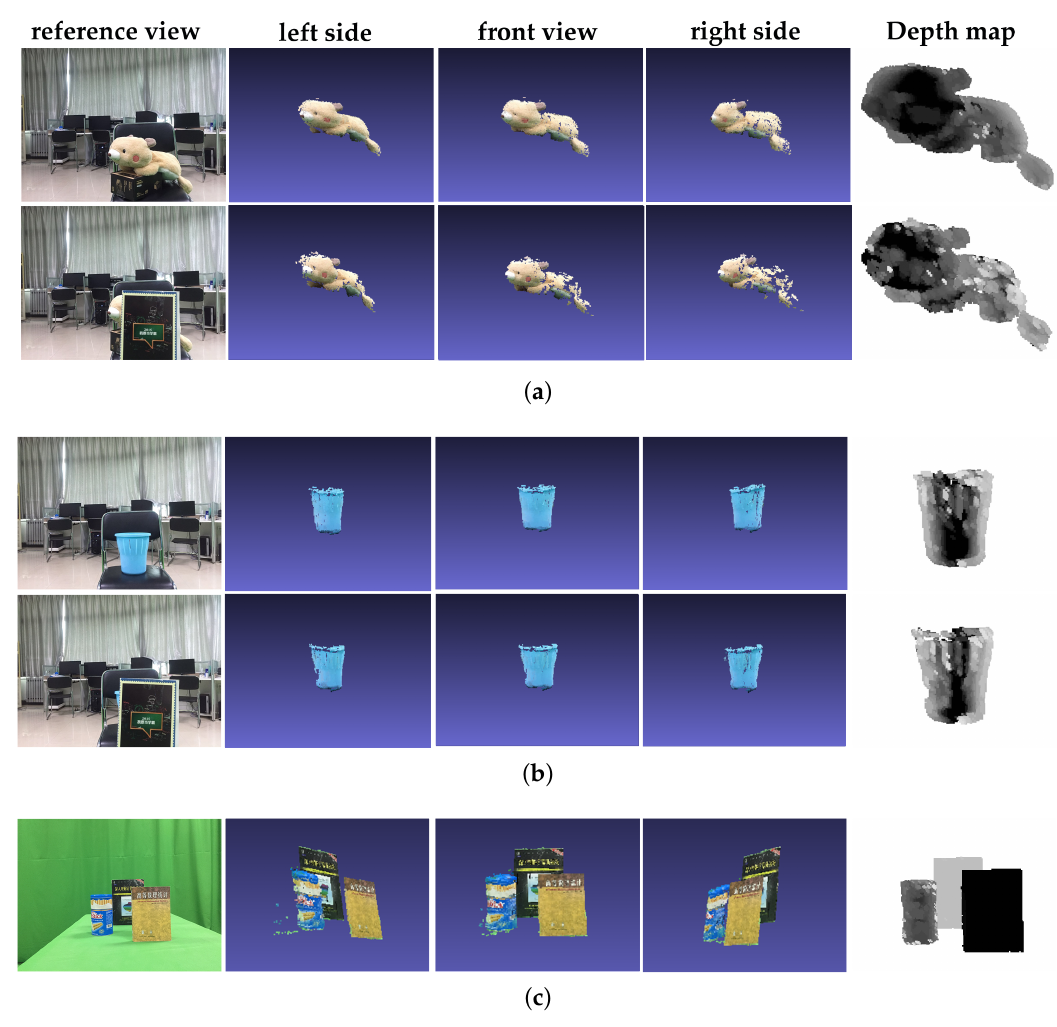
Figure A4. Indoor scene. ( a ) Toy-bear scene of reconstruction. ( b ) Trash-bin scene of reconstruction. ( c ) Book scene of